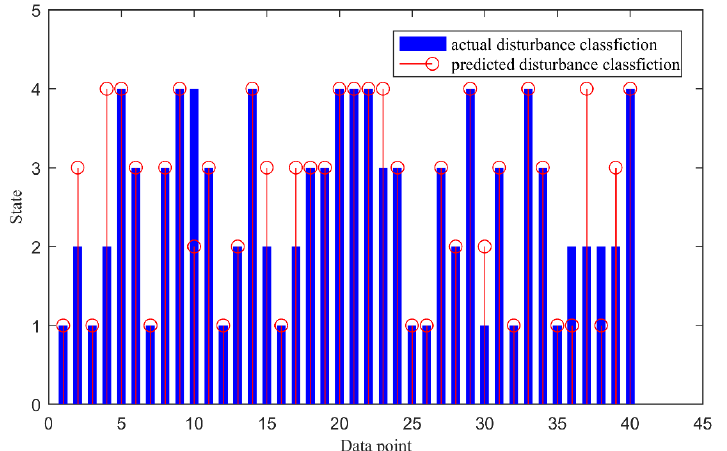
Figure 29. The BP classification diagram of the value of the components decomposed by VMD calculated by CMFE.